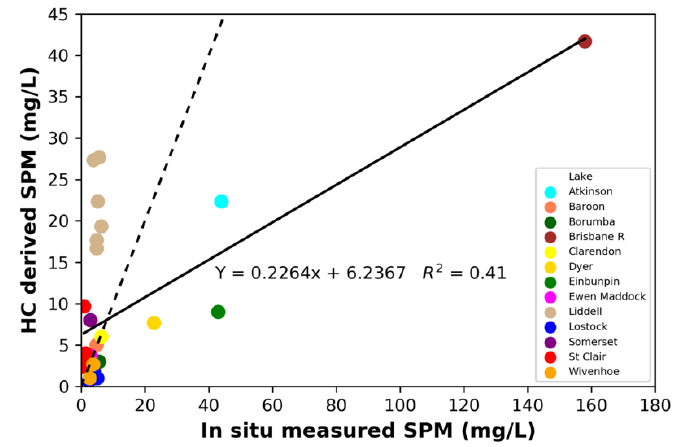
Figure 14. Relationship between in situ-measured suspended particulate matter (SPM) and HydroColor-derived SPM (mg/L) shown for individual lakes. The solid line represents the regression through the data, and the dashed line represents the 1:1 relationship.